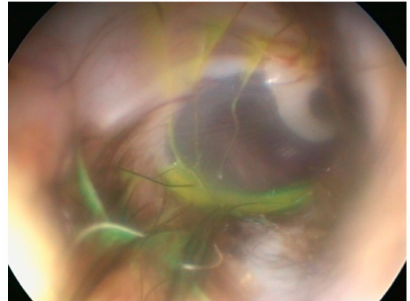
Figure 5. External ear canal cleaned and dried, pre myringotomy. Note that a trace of fluorescein re- mains. Courtesy Elisabeth Reinbacher, Clinical Unit of Internal Medicine Small Animals, Department for Companion Animals and Horses, Vetmeduni Vienna, Veterinärplatz 1, 1210 Vienna, Austria